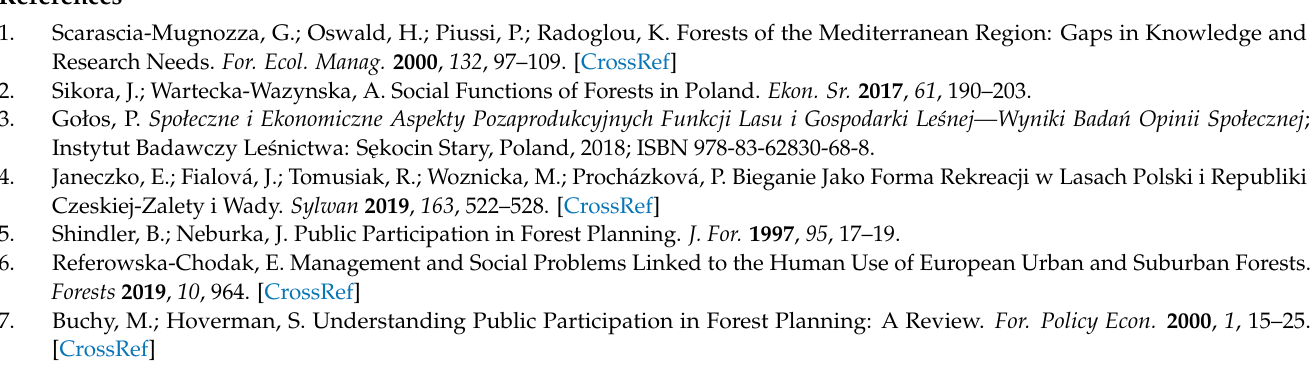
Figure A1. Photos of the educational boards used in the online